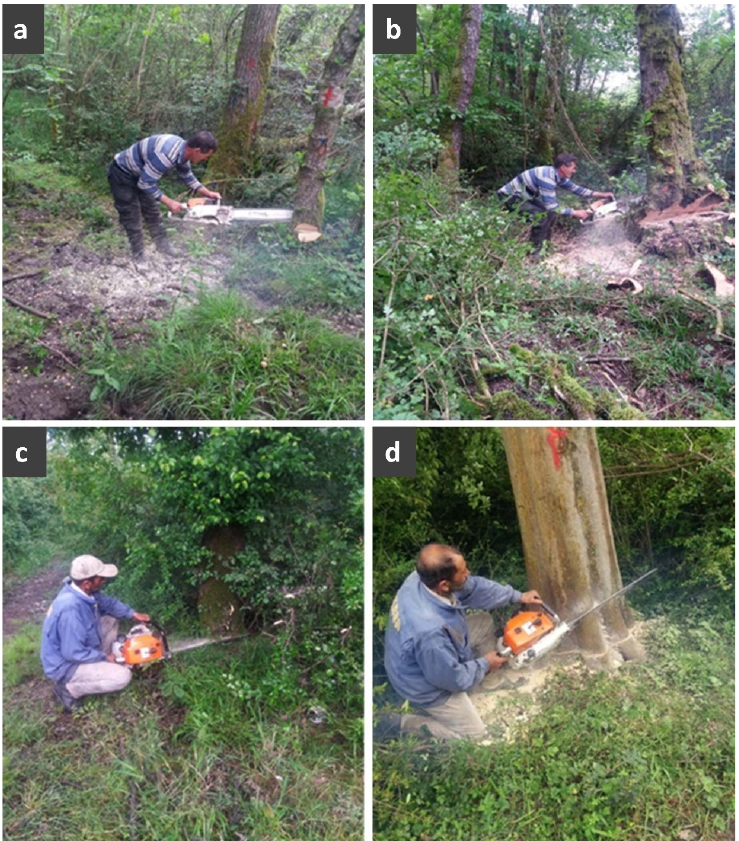
Figure 1. The examined body postures: ( a ) back bent forward with straight legs (stoop); ( b ) back bent forward with bent legs (flexed stoop); ( c ) squatting (squat), and ( d ) kneeling on one knee (half-kneel).